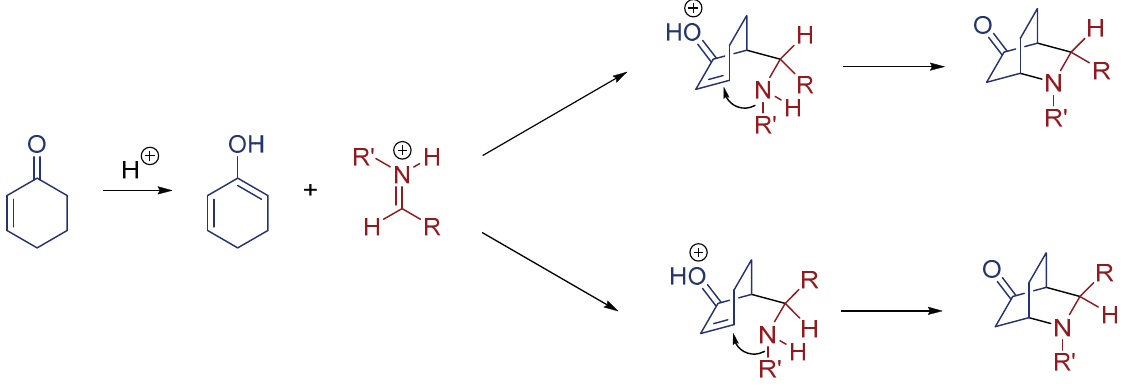
Figure 6. Proposed direct aza-Diels-Alder reaction of cyclohexanone with aldimines. The 4-aminobenzopyrans and their furan-fused derivatives appear to be very appealing targets for synthetic chemists due to their useful biological properties such as anti-hypertensive and anti-ischaemic activities. In 2010, Fochi and co-workers developed the BINOL-phosphate catalyzed inverse-electron-demand [4+2] cycloaddition reactions of different salicylaldehyde-derived N -arylimines with electron-rich dienophiles such as 2,3-dihydro-2 H -furan, 2-vinylindole and N -vinylcarbamate towards chiral 4-aminobenzopyran derivatives (Scheme 7)